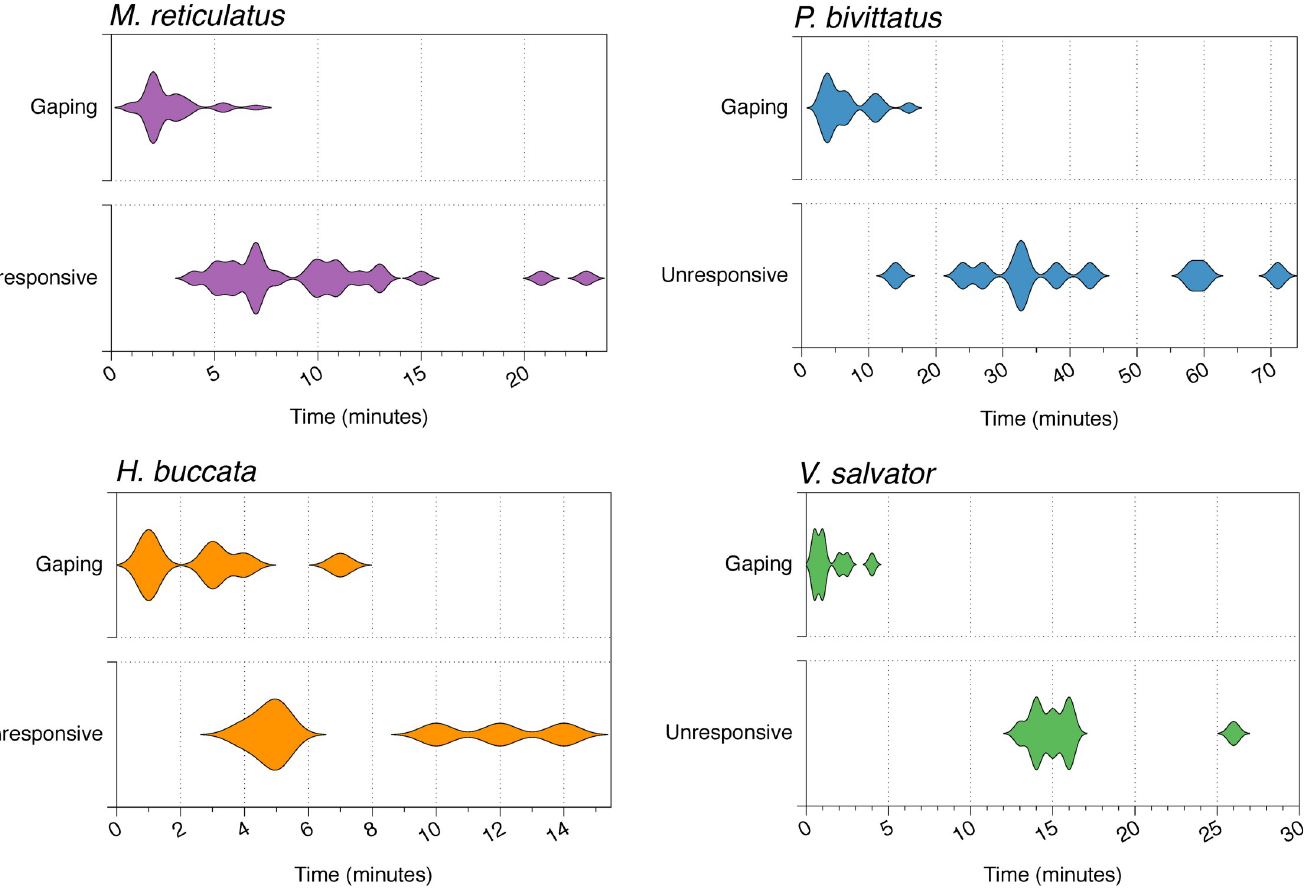
Fig 1. Variation in timing (in minutes) of key behavioural changes in (a) Malayopython reticulatus , (b) Python bivittatus , (c) Homalopsis buccata , and (d) Varanus salvator subject to carbon dioxide (CO 2 ) exposure. Gaping: the time at which the mouth of the specimen opened. Unresponsive: the time the specimen had ceased movement and became unresponsive to stimuli. Thicker parts of the violin plots represent CO 2 exposure times where the behaviour was most often observed. Note the different time scales represented on the x-axes of each